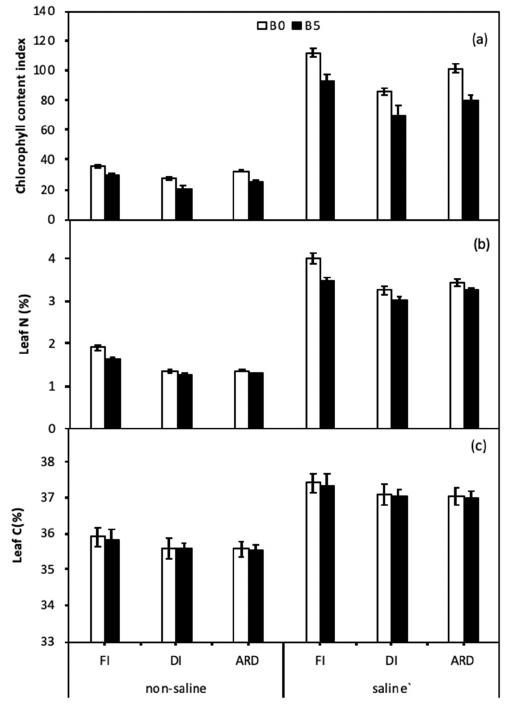
Figure 3. Leaf chlorophyll content index ( a ), Leaf N ( b ), and C ( c ) content as affected by biochar, irrigation regimes, and salinity. B0 and B5 indicate biochar levels, respectively. FI, DI, and ARD indicate full irrigation, deficit irrigation, and alternate root-zone drying irrigation, respectively. Error bars indicate ± SE ( n = 4). SE indicates standard error.